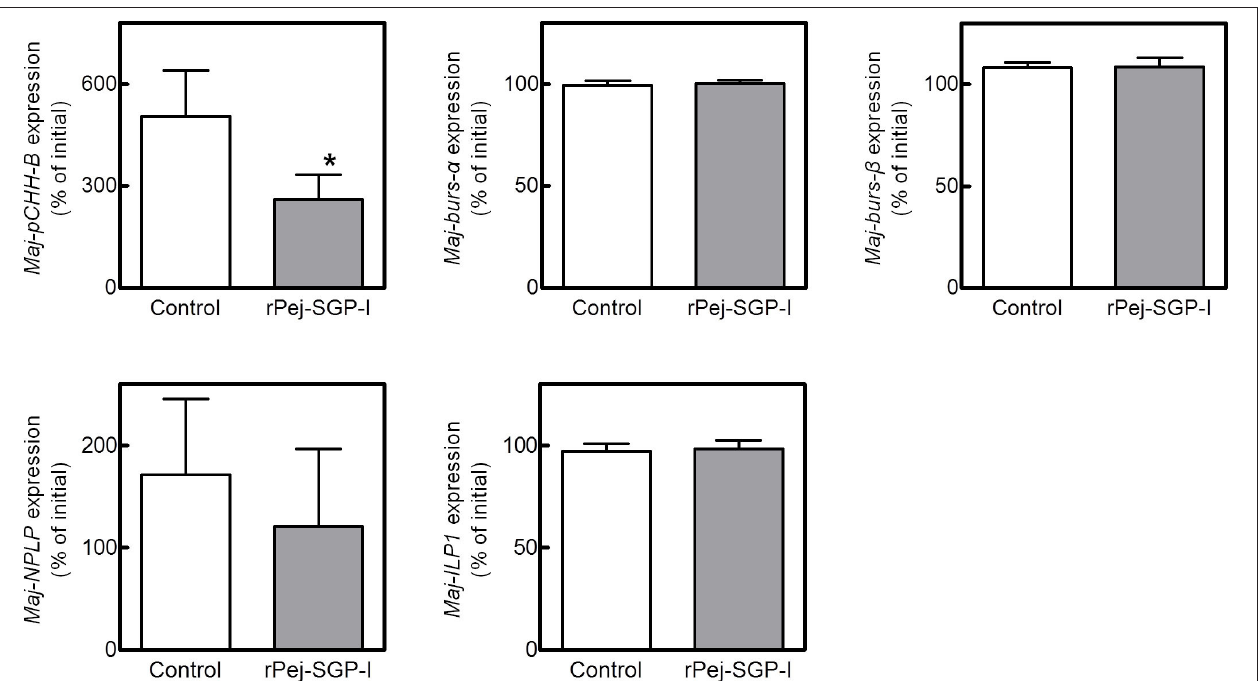
FIGURE 5 | Effect of rPej-SGP-I on mRNA levels of the putative hormones in the ovary. Relative expression levels have been shown as the percentage change relative to that of the initial expression (mean ± SEM, n = 6). Statistical differences between control and rPej-SGP-I-treated groups were analyzed by the Wilcoxon signed rank test (* P <